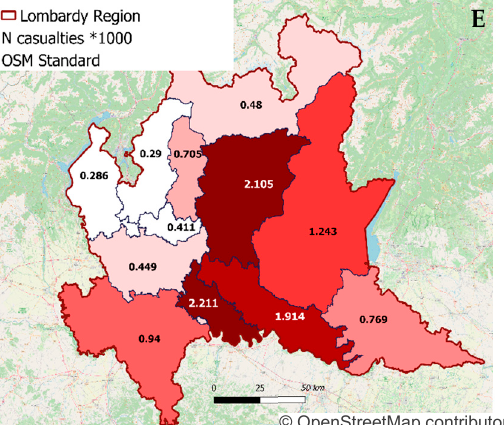
Figure 3. ( A ) Linear regression between the number of ambulances dispatched on the territory and casualties due to COVID-19, according to ISTAT, from 1 January to 30 March 2020, both normalized by the resident population (values per 1000 people) for each of the 12 provinces in which Lombardy is sub-divided; ( B ) Lombardy map with the number of ambulance dispatches for each province from 1 January to 30 March 2020 (mapped in panel E ); ( C ) linear regression between the number of emergency calls to 112 and casualties due to COVID-19, according to ISTAT, from 1 January to 30 March 2020; ( D ) Lombardy map with the number of calls to the emergency number 112 for each province